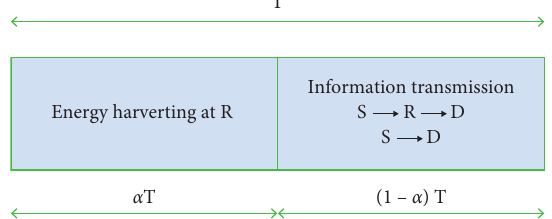
Figure 1: System model.